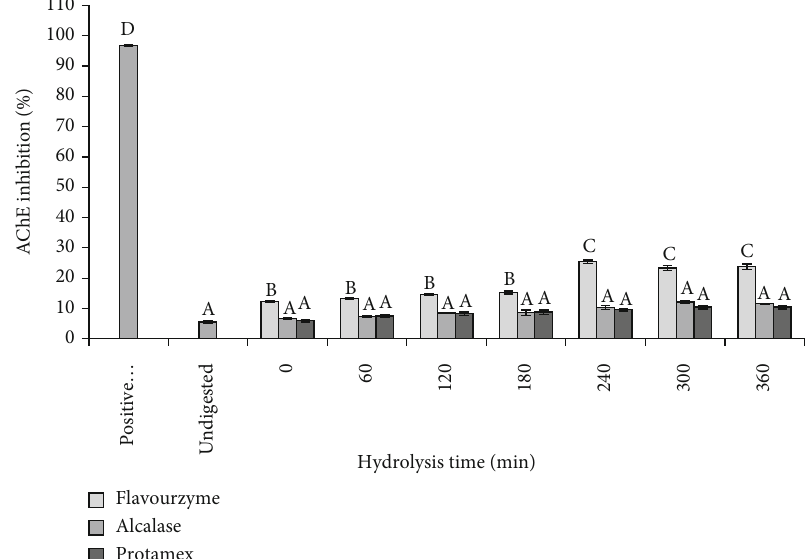
Figure 1: Acetylcholinesterase inhibitory capacity of three enzyme-treated royal jelly hydrolysates. The di ff erent letters have mean values that are signi fi cantly di ff erent ( p < 0 : 05 ) compared to the positive control and unhydrolyzed